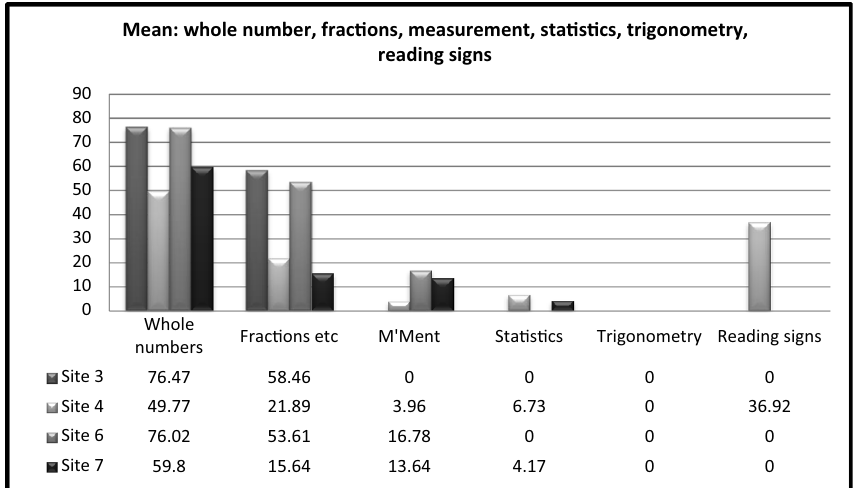
Table 2 Scenario-based student assessment